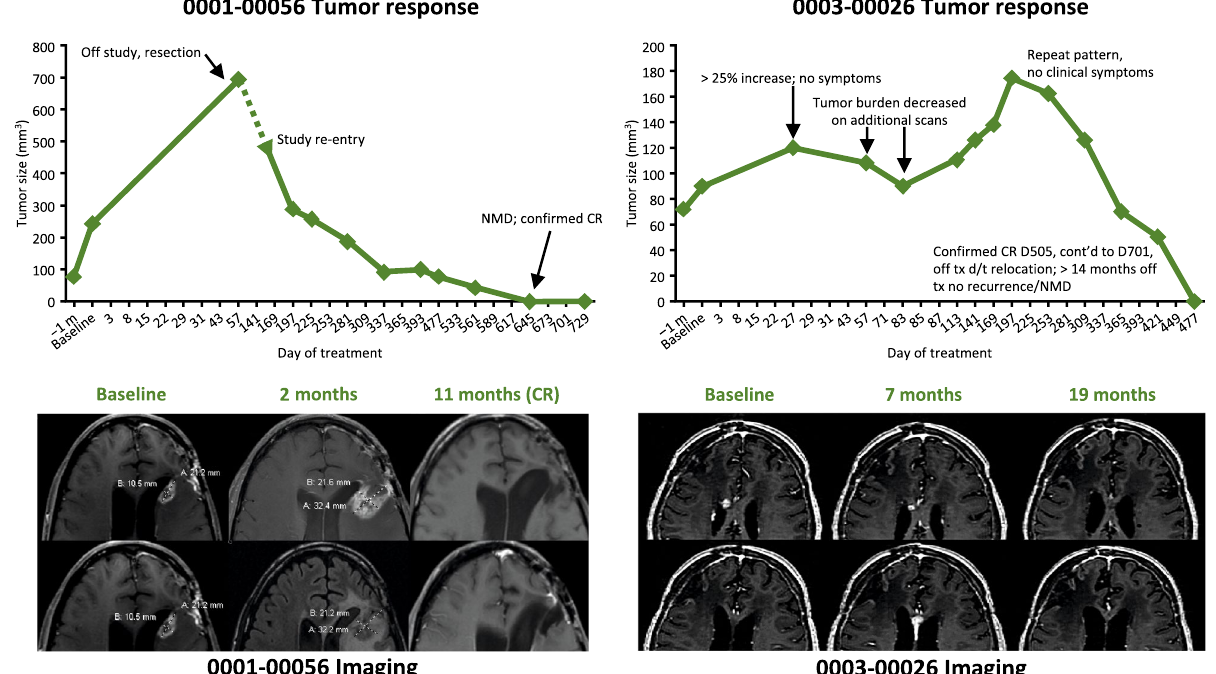
Figure 3. Change in tumor size over time and imaging for the two glioblastoma patients who achieved an immune-related complete response. CR complete response, D day, m month, NMD no measurable disease, tx